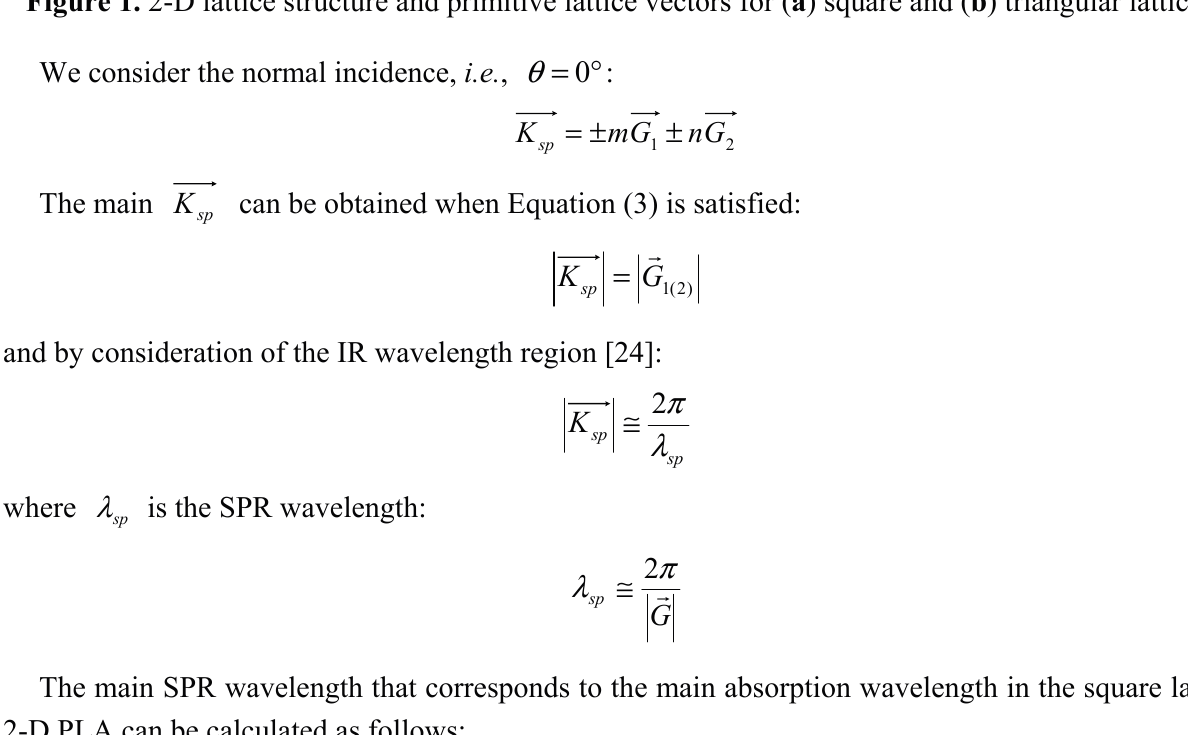
Figure 1. 2-D lattice structure and primitive lattice vectors for ( a ) square and ( b ) triangular